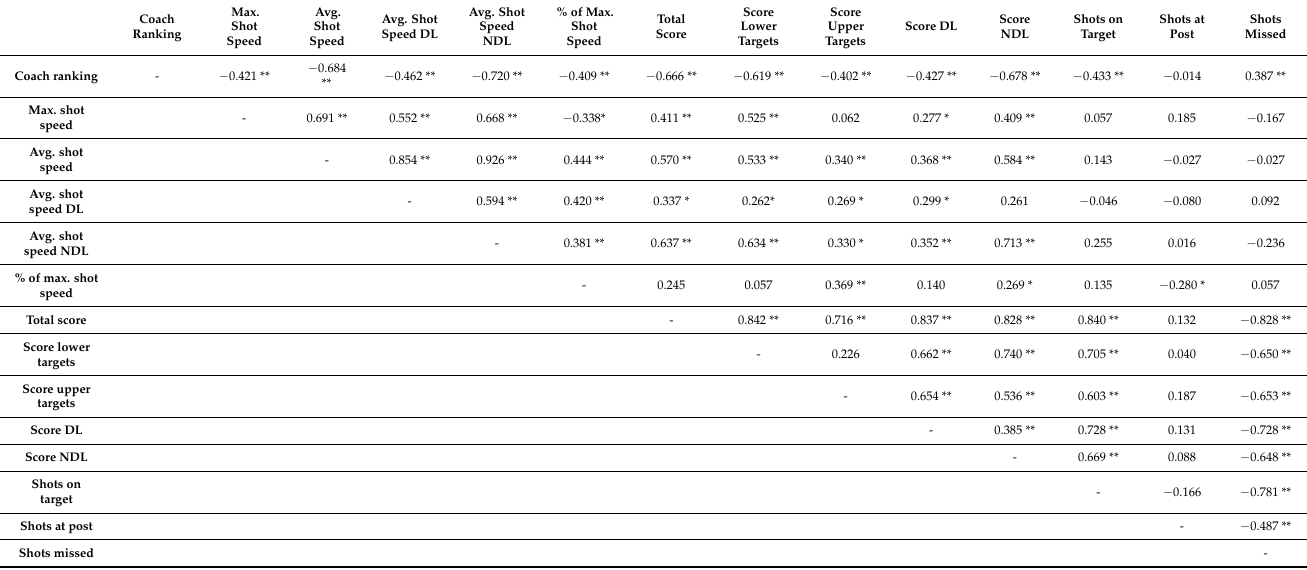
Table 3. Spearman correlation analysis of test variables and coach